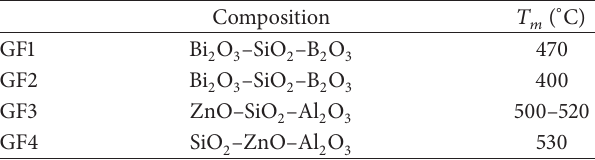
Figure 1: Working principle and device structure of a dye-sensitized solar cell (DSC). An organic electrolyte with the redox couple I − /I 3 − transports the positive charge between the mesoscopic photoelec- trode and the counter electrode. Table 1: Main composition of glass frits for sealing.